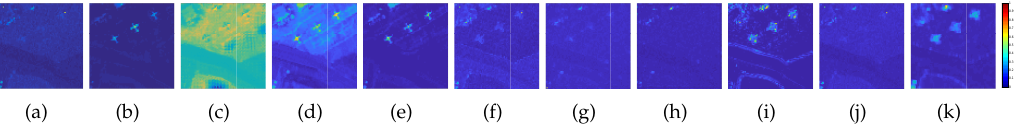
Figure 12. Two-dimensional plots of the detection results obtained by different methods for the San Diego dataset. ( a ) GRX; ( b ) BJSRD; ( c ) LSAD; ( d ) LRASR; ( e ) LSMAD; ( f ) CBAD; ( g ) CRD; ( h ) LRX; ( i ) LKRX; ( j ) OSP; and ( k ) BDSLRR.